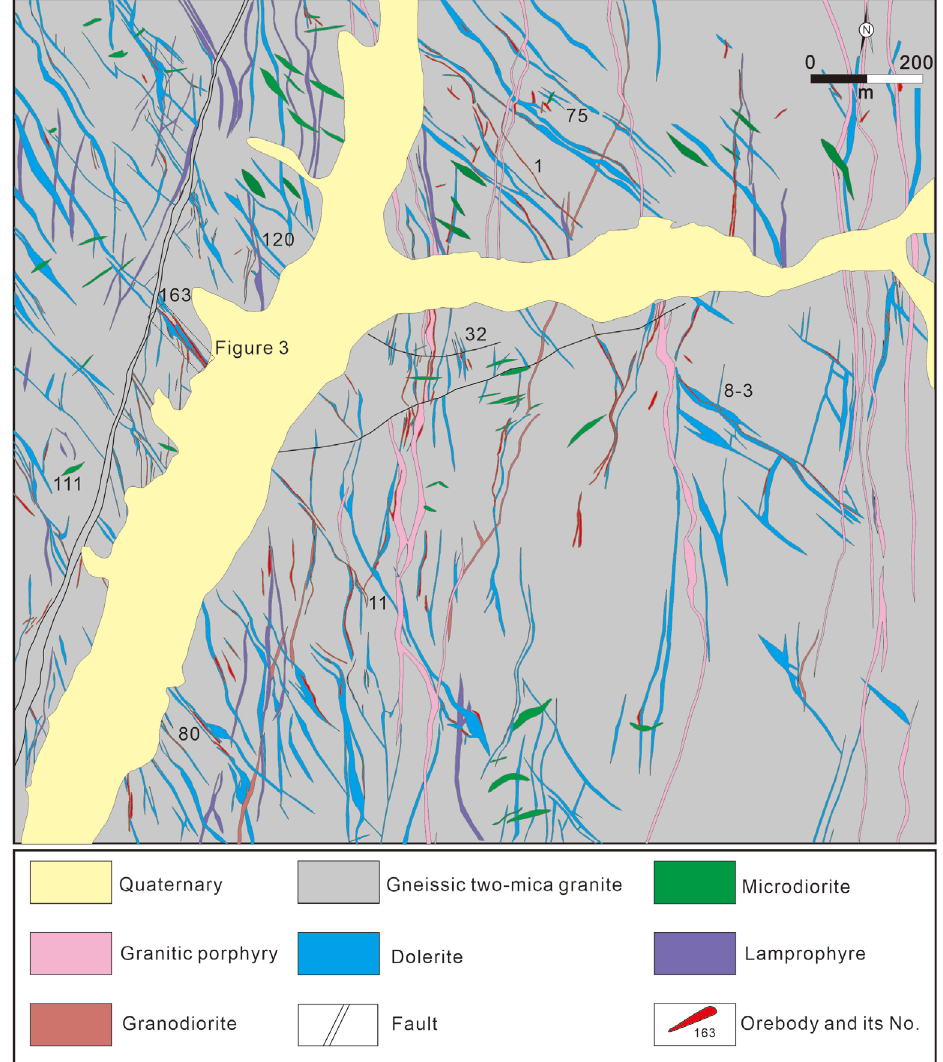
Figure 2. Simplified geologic map of the Wulong gold deposit showing the distribution of major host rocks, orebodies, and alteration zones. Modified from [10].